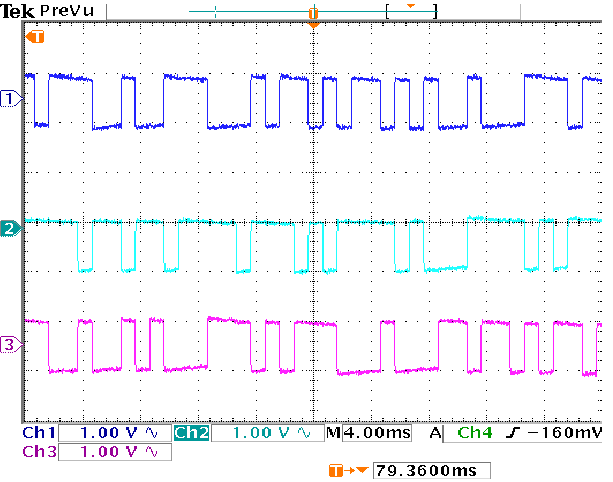
Figure 13. Rotor current.